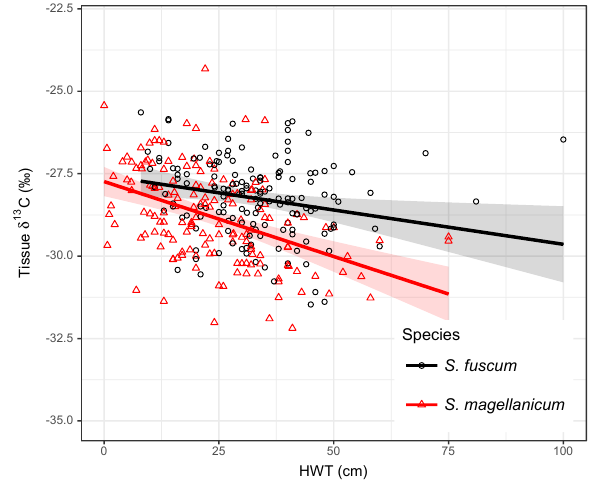
Figure 3. Association between modelled annual mean δ 18 O precip values and δ 18 O values in two Sphagnum species. Data show site means for each species and error bars represent the standard devi- ation (at some sites only one sample of a species was taken). Re- gression lines with different intercepts ( P < 0 . 001, Table 2) illus- trate the relationship between modelled δ 18 O precip and Sphagnum δ 18 O. Equations: S. fuscum , 26 . 36 + 0 . 43 × δ 18 O precip ( n = 1–2, N site = 80); S. magellanicum , 25 . 53 + 0 . 43 × δ 18 O precip ( n = 1–2, N site = 83). Shaded areas indicate approximate 95% confidence in- tervals (2 × SE) of the regression coefficients that do not include the uncertainty of the random